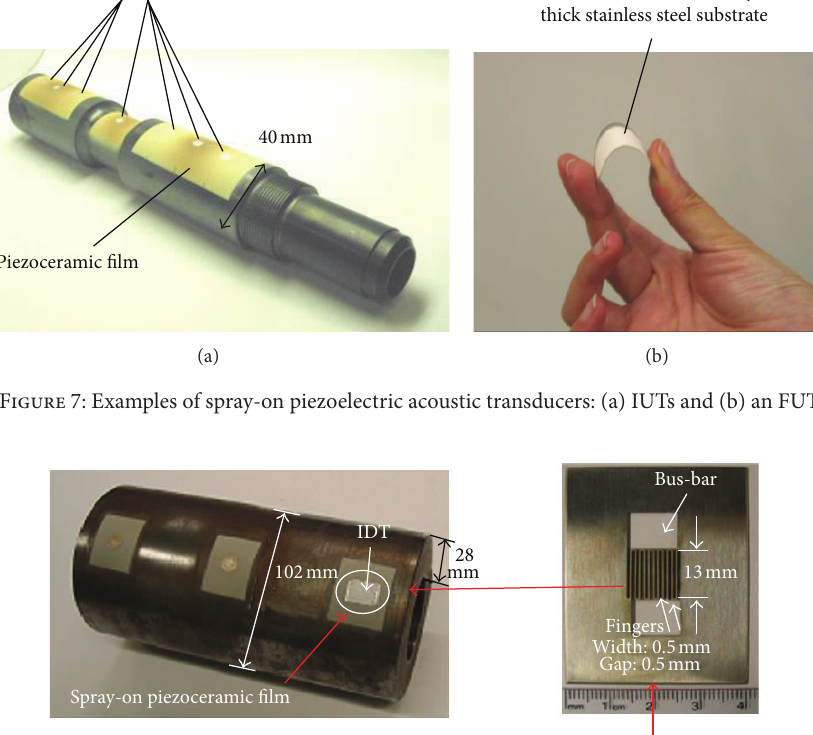
Figure 8: An interdigital transducer fabricated on a steel pipe (left) for generation and detection of Rayleigh surface acoustic waves. The interdigital top electrodes were silver-pained with help of a mask (right).